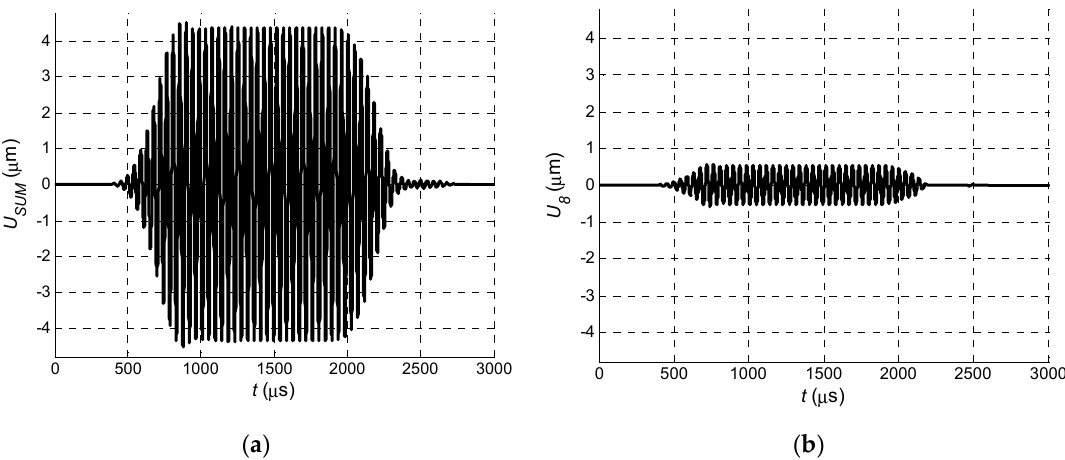
Figure 6. Waveforms of normal displacements: ( a ) at the output of the entire receiving array and ( b ) at the output of receiving array Element 8.